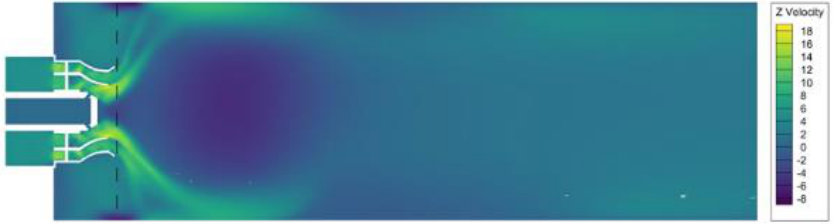
Figure 13. Computational mesh for CFD model.